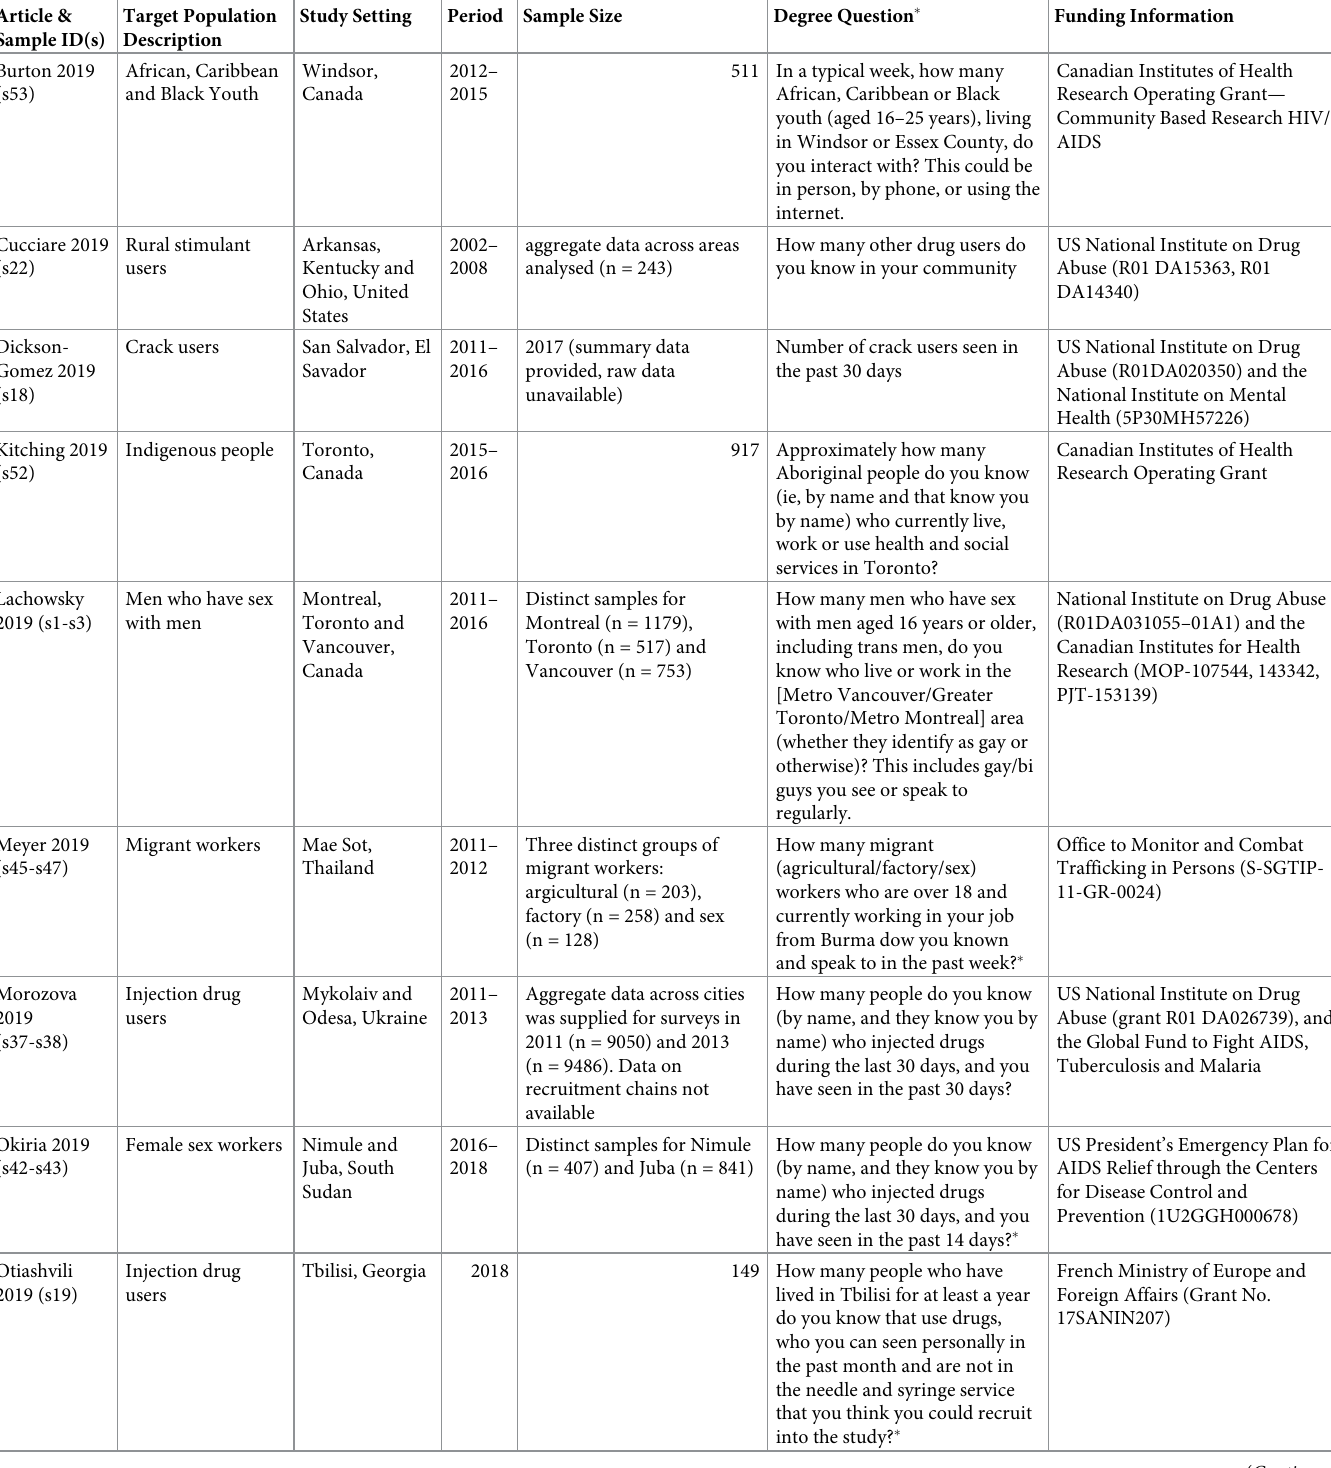
Table 1. Description of studies contributing information about reported degree and recruitment